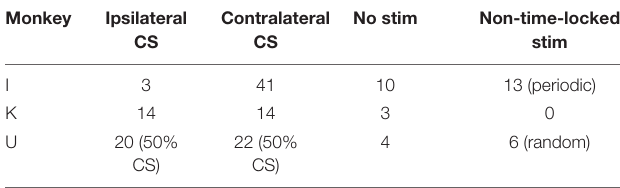
TABLE 1 | Number of experiments by